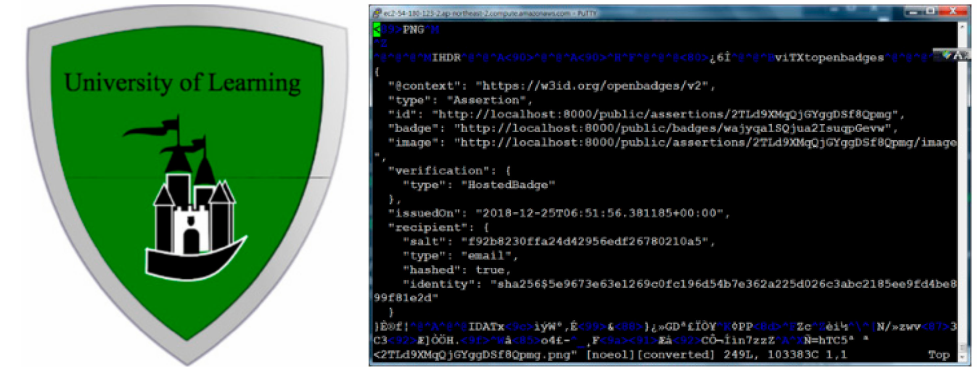
Figure 7. A digital badge example and baked information within the badge